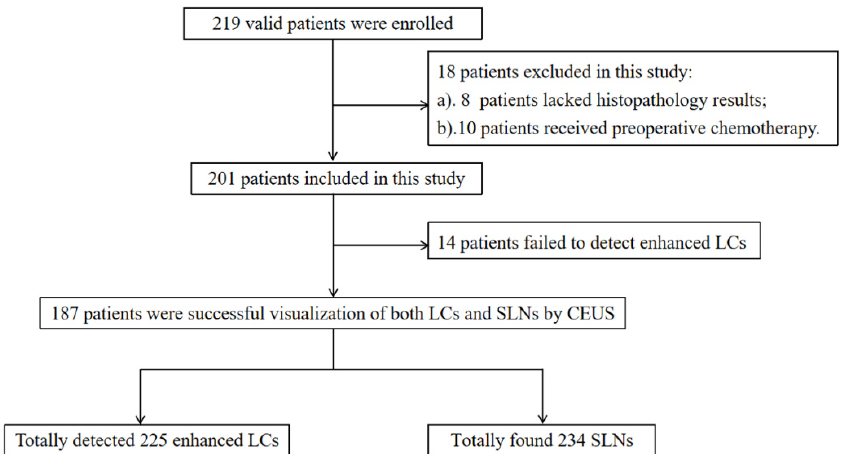
Figure 1. Flowchart of the study (CEUS = contrast-enhanced ultrasound; LC = lymphatic channel; SLN = sentinel lymph node).